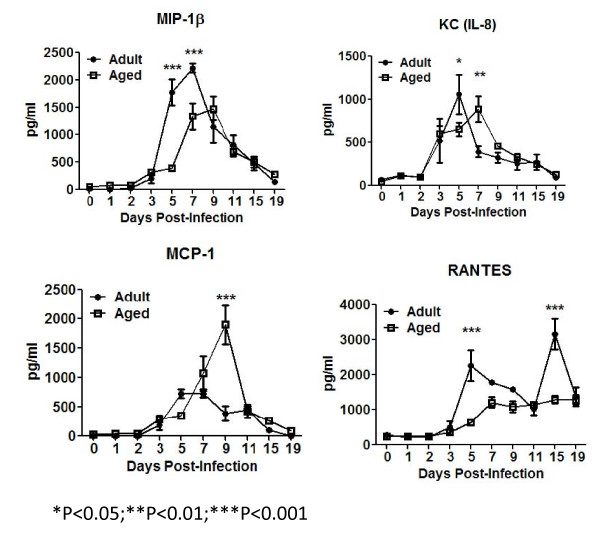
Chemokines. Several chemokines were determined in the lung supernatants of aged and adult mice infected with influenza virus. MIP-1β increased and peaked earlier in adult animals (black squares) (A). KC increased similarly in the lungs of adult (black circles) and aged (white squares) mice, however peaked earlier in adult animals (B). MCP-1 had a mild early peak in adult mice (black circles), while a higher delayed peak in aged animals (white squares) (C). There was a biphasic expression pattern of RANTES in adult mice (black circles) with a peak in concentrations at day 5 and 15 (D), while aged animals (white squares) had a very mild increase in this chemokine. The overall delayed production of chemokines correlated with delays in infiltration kinetics of innate and adaptive cells the lungs. The graphs represent cumulative results of two different experiments. The arithmetic mean (± SEM) concentration of 4-6 mice assayed at each time point was plotted. Stars indicate statistical difference between aged and naïve animals. *P < 0.05. **P < 0.01. ***P < 0.001.